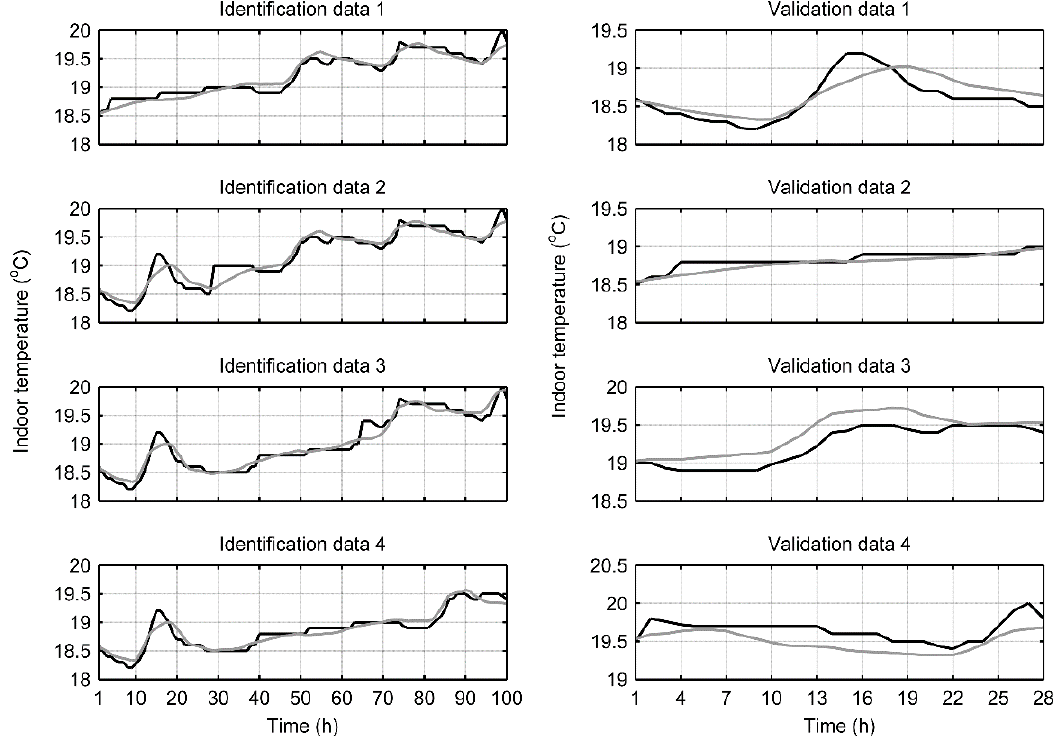
Figure 4. Cross-validation results with data from building A with model structure P1P3. Black line is the measured indoor temperature and grey line is the estimated indoor temperature. For validation data sets, a 28-h ahead prediction was simulated with measured data. The RMSE for the identification data sets 1, 2, 3 and 4 was 0.09 ◦ C, 0.13 ◦ C, 0.11 ◦ C and 0.09 ◦ C, respectively, and for the validation data sets 1, 2, 3 and 4 it was 0.16 ◦ C, 0.07 ◦ C, 0.18 ◦ C and 0.18 ◦ C, respectively. Correlation coefficients for the identification data sets 1, 2, 3 and 4 were 0.97, 0.96, 0.98 and 0.96, respectively, and for the validation data sets 1, 2, 3 and 4 they were 0.84, 0.89, 0.94 and 0.79,